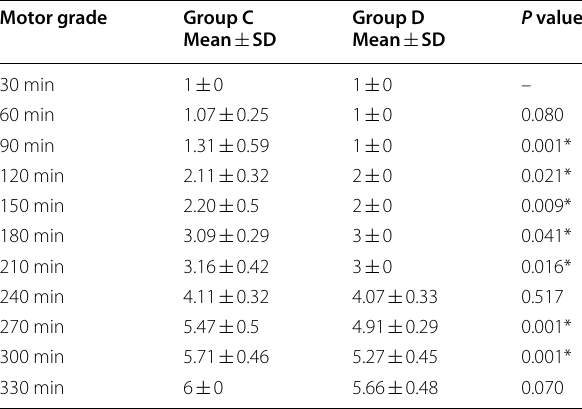
Table 3 Motor grade recorded in both the groups perioperative and postoperative period